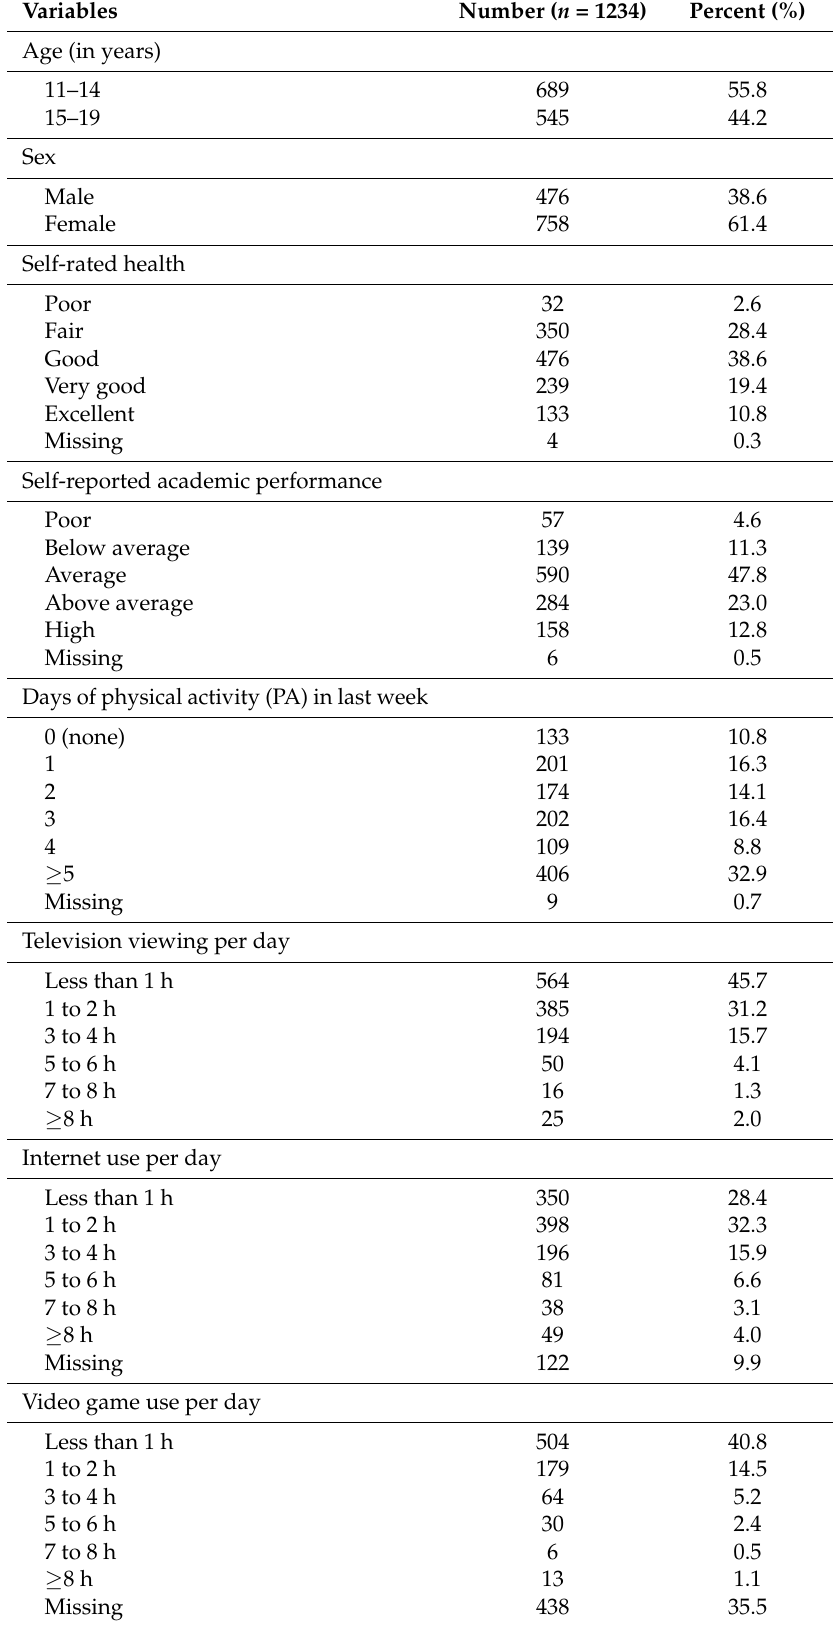
Table 1. Characteristics of the study